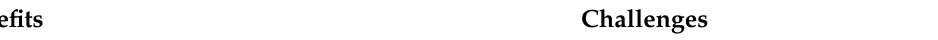
Table 1. Benefits and implications of AVs